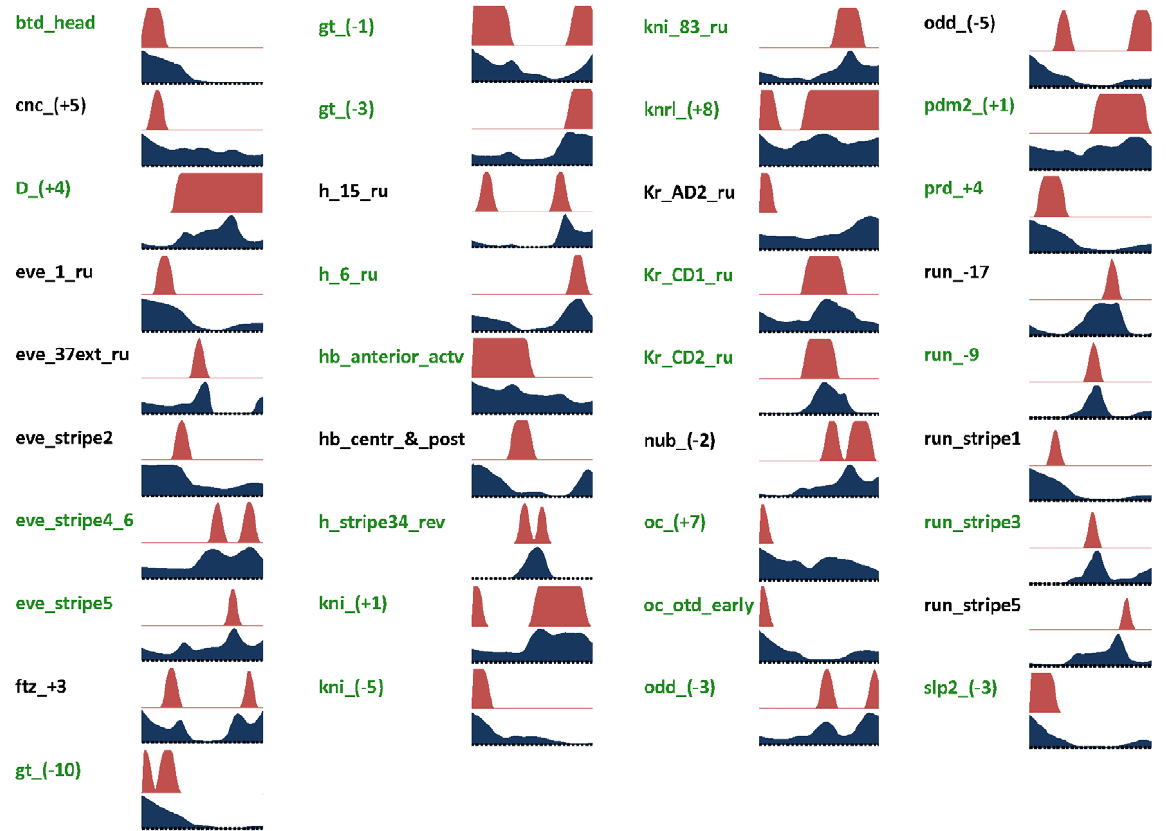
Figure 3. Model predictions. The predicted expression profile of the DirectInt model (with Bcd and Kni self-cooperativity) is shown (blue) in comparison to the known readout (red), for all CRMs in the data set. Each expression profile is on a scale of 0 to 1 (y-axis), and shown for bins 20 (left) to 80 (right) of the embryo. Labels in green indicate CRMs where the CC is greater than 0.65.